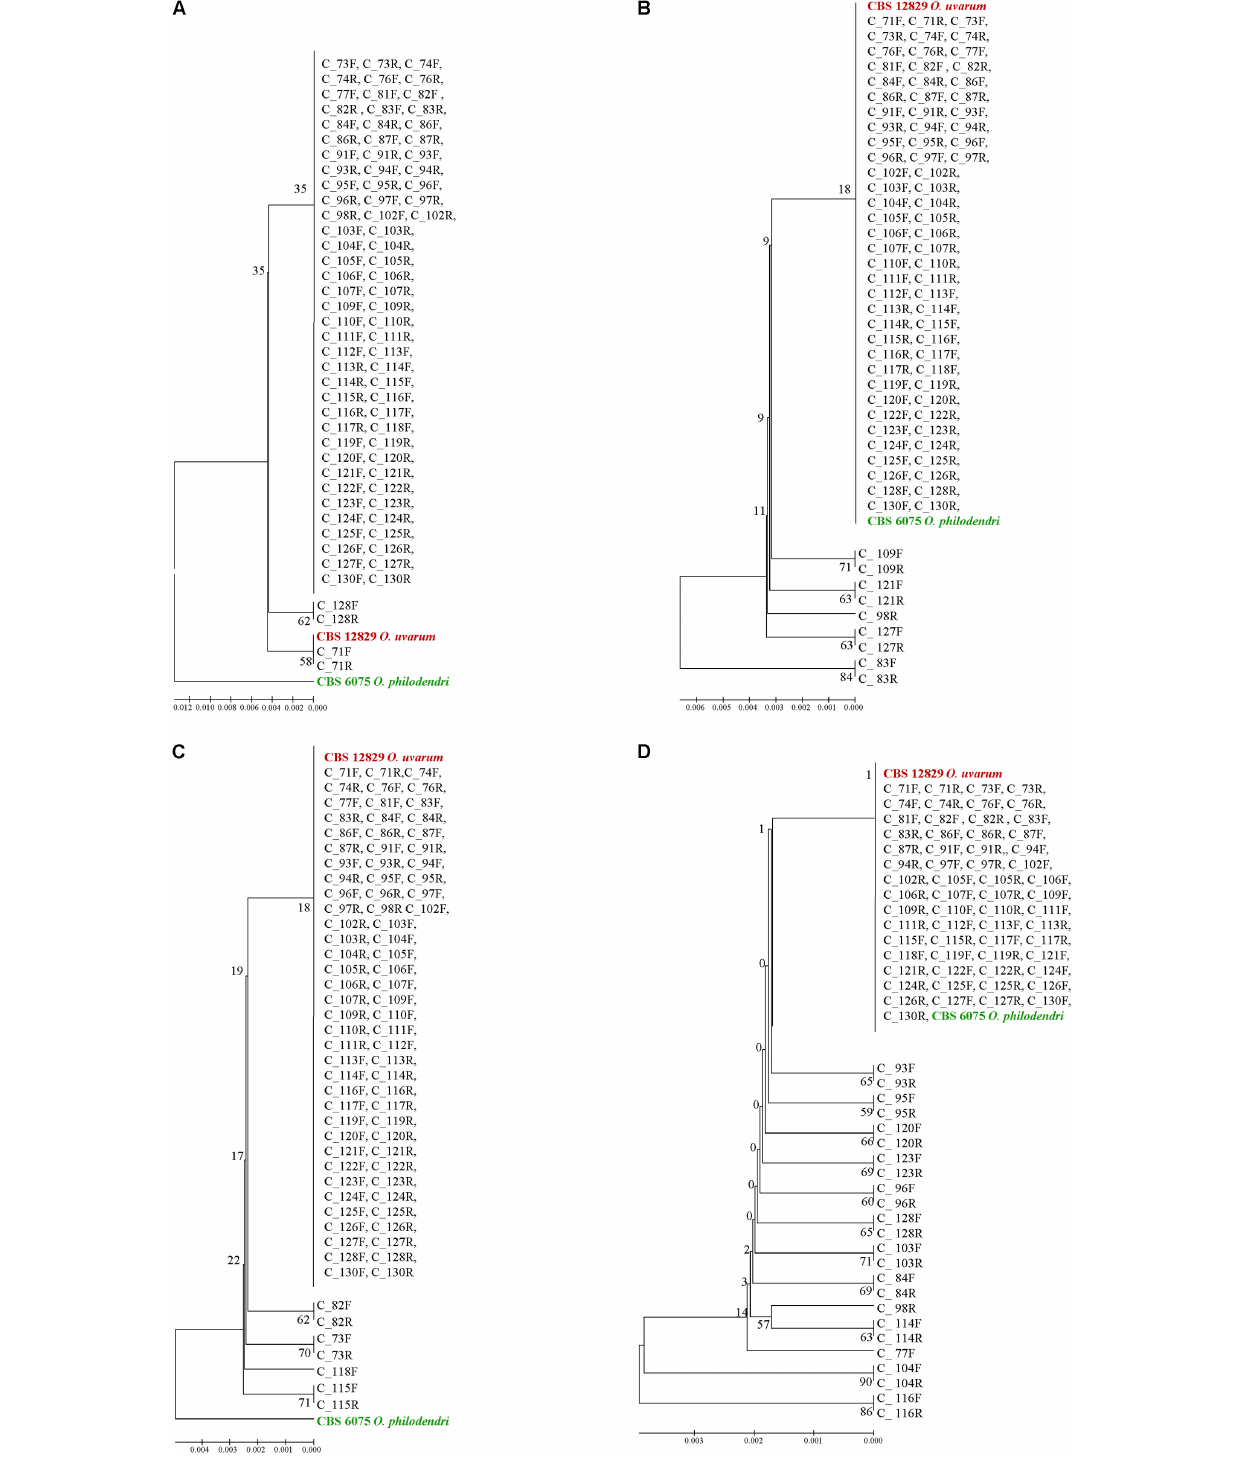
Frontiers in Microbiology |